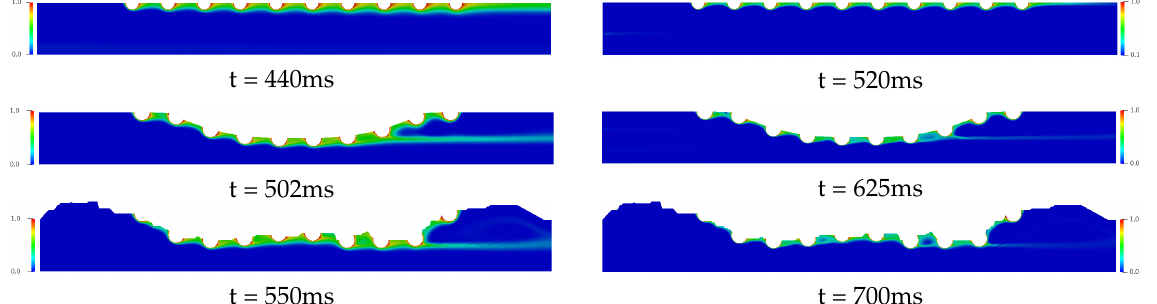
Figure 9. The spatial and temporal distribution of the concentration diffusion using the Sc = 100 ( left column ) and Sc = 1000 ( right column ) drug coefficients for the Straight Channel, the Curved channel and the Real Channel with the drug-eluting stent. Both cases have a similar dynamic where it is possible to observe a decrease in the drug diffusion in the bloodstream when the Schmidt number is increased, it becomes a purely convective flow. Therefore, drugs with low mass diffusivity coefficients should be taken into account at drug-eluting stent design, in order to decrease the chemical species dissolution in the